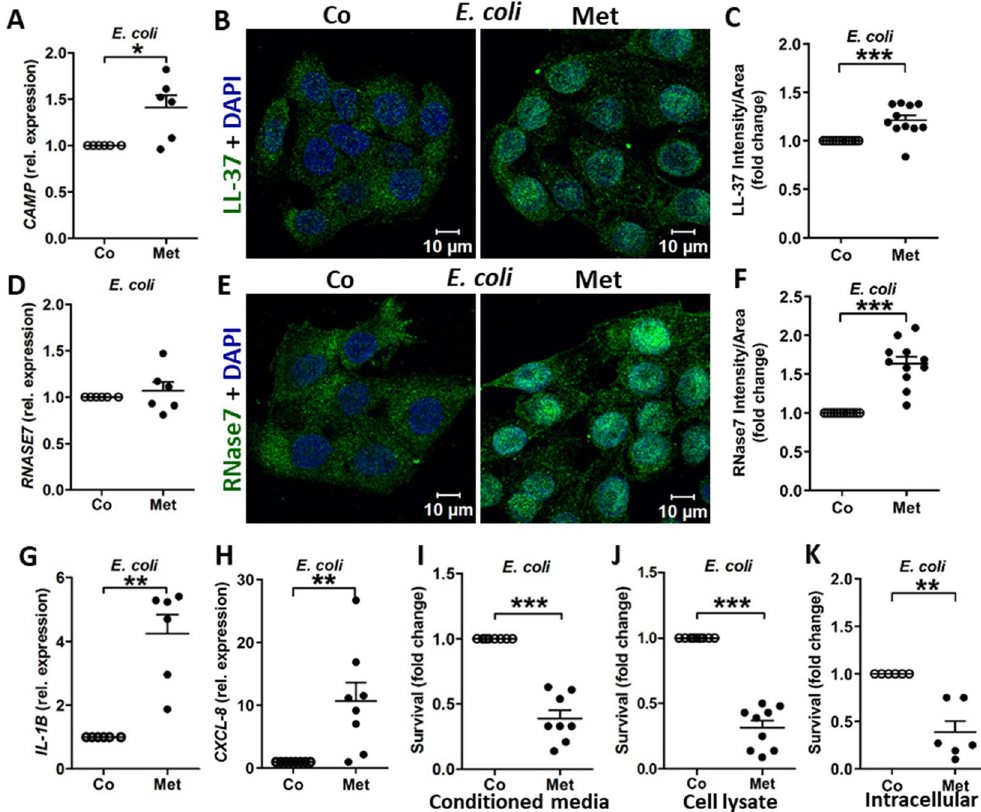
Figure 5. Metformin treated uroepithelial cells show higher antibacterial activity. ( A ) Expression of CAMP in 5637 uroepithelial cells measured after E. coli infection at MOI 20 for 15 min (n = 3, performed in duplicates). ( B ) Representative microscopic images of LL-37 expression after 2 h E. coli infection with MOI 10 and ( C ) relative average intensity analysis (n = 3, each consisting of 3–4 random view fields). ( D – F ) Corresponding expression pattern of RNase7 at mRNA and protein level. ( G , H ) Expression of IL1B , CXCL8 in infected 5637 uroepithelial cells (n = 3–4, performed in duplicates). ( I ) E. coli survival after 6 h incubation in uroepithelial cells conditioned media and ( J ) 30 min in the cell extract (n = 3). ( K ) Intracellular survival of E. coli after 2 h post gentamicin treatment and compared to initial inoculum (n = 3). All survival experiments were performed in duplicates or triplicates. Human uroepithelial cells, 5637 were used throughout. Metformin (Met, 4 mM) treatment for 24 or 36 h for mRNA and protein analysis or survival assays respectively, compared to only vehicle treated control. Data are presented as mean with SEM. Significance levels *P < 0.05, **P < 0.01, ***P <